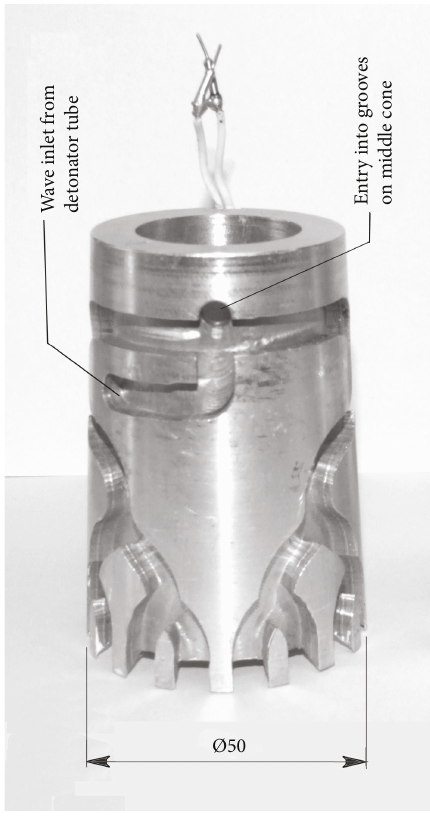
Figure 5: Photograph of the outer distributor cone. On top there is the trifurcating entrance, following the trajectories presented in Figure 6. The two electric conductors on the top of the picture lead to ionisation detectors.